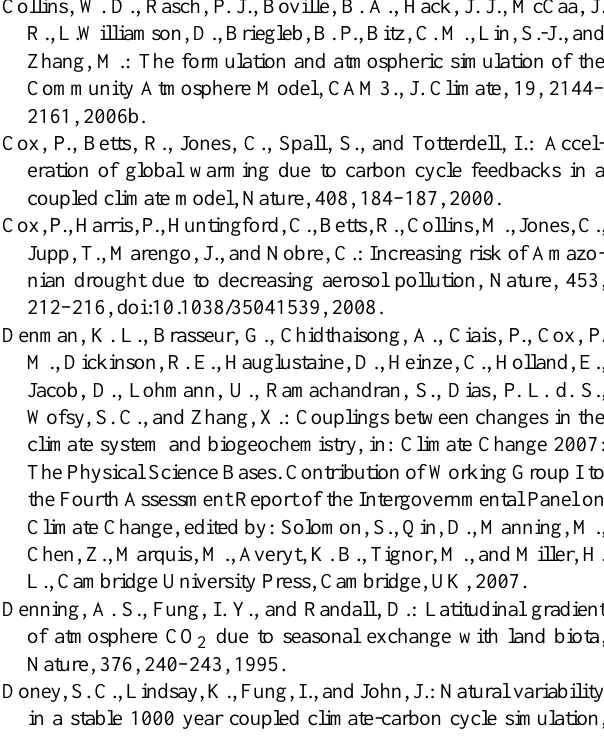
Fig. A7. Ocean mixed layer depth (m) differences for 2080–2099 versus the first twenty years of the same simulation for each case: (a) mean change for 3 ensemble base case members, (b) differences from base case differences for interactive dust (DUST), (c) differences from base case for interactive aerosols (AEROSOL), (d) difference between 2 × DUST and 0.5DUST cases, (e) differences from base case for case of NONEQ, and (f) differences from base for case of TRAJ. Only changes significant at the 95% level are shown in color. Note that panels (b) , (c) , (e) and (f) show differences from the 3 BASE case differences from the beginning of the simulation (for example: (DUST2080-2099 minus DUST-1870-1889) minus (BASE2080-2099 minus